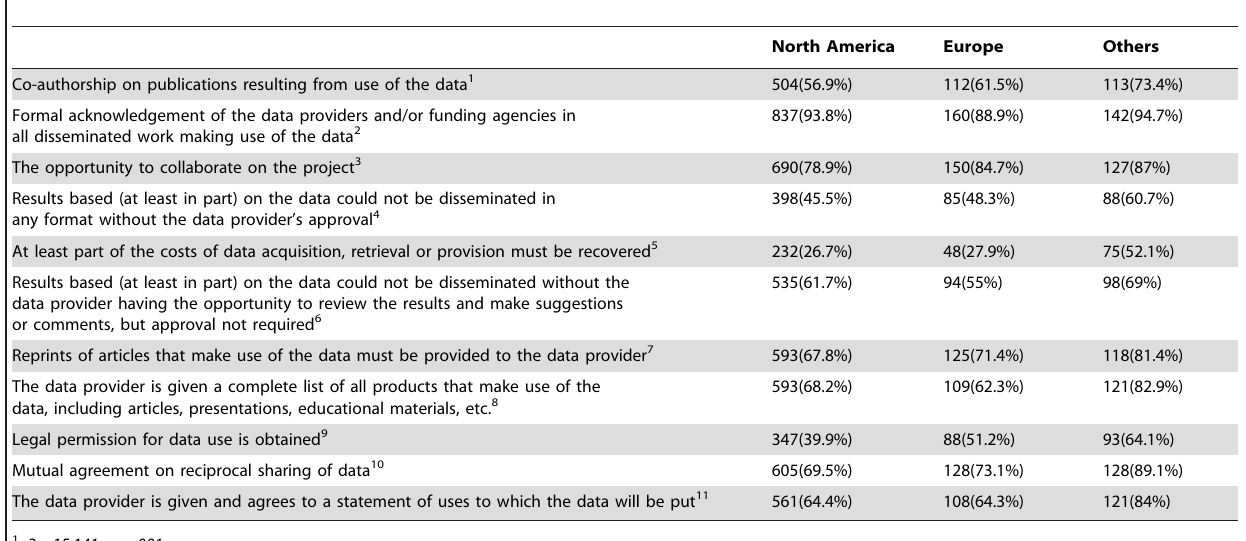
Table 36. Others using data by geographic